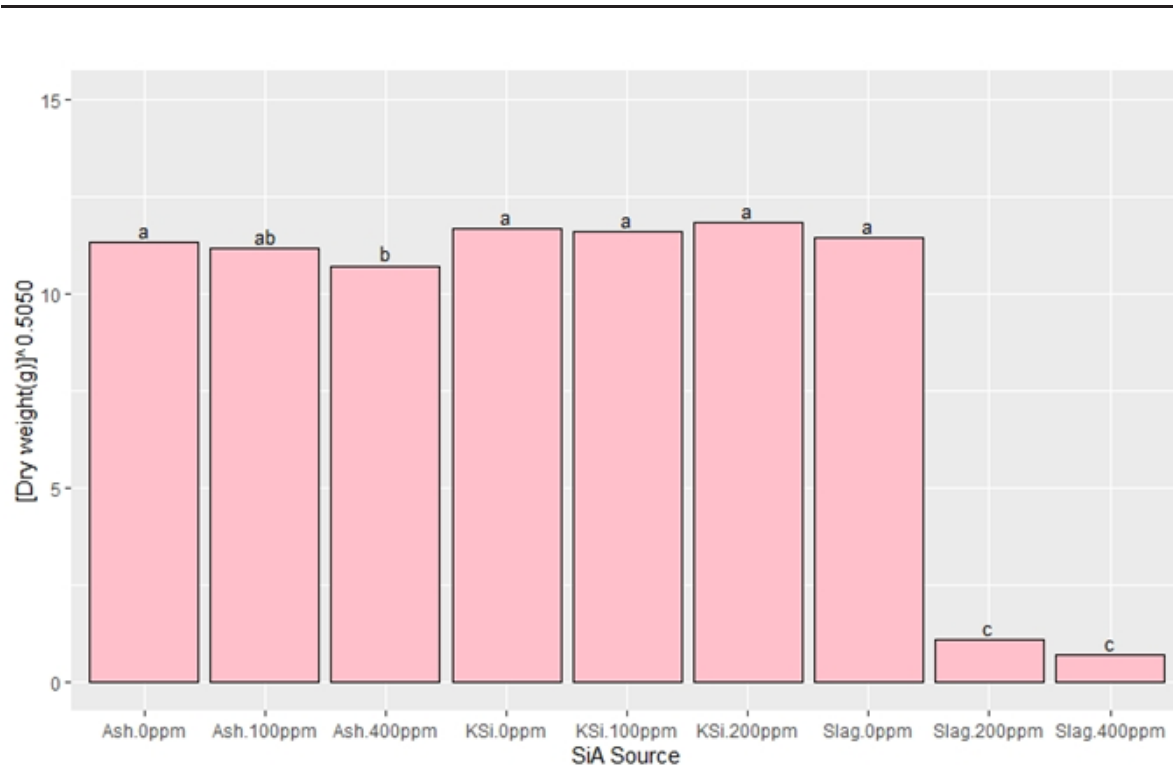
] 0.5050 . Significance levels were obtained with Tukey test, α t(g)